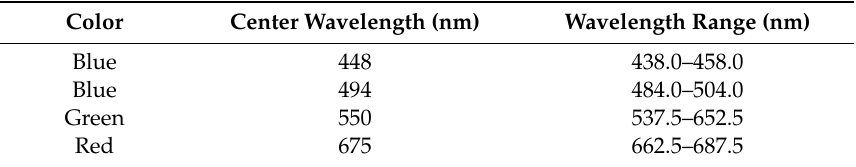
Table 1. Wavelength bands used to measure reflectance with the multispectral sensor installed on the UAV used in this study. Wavelength bands were limited to the visible light ( λ between 400 and 700 nm) since UV ( λ < 400 nm) and infrared ( λ > 700 nm) bands are strongly absorbed by water, and not preferable to infer water quality